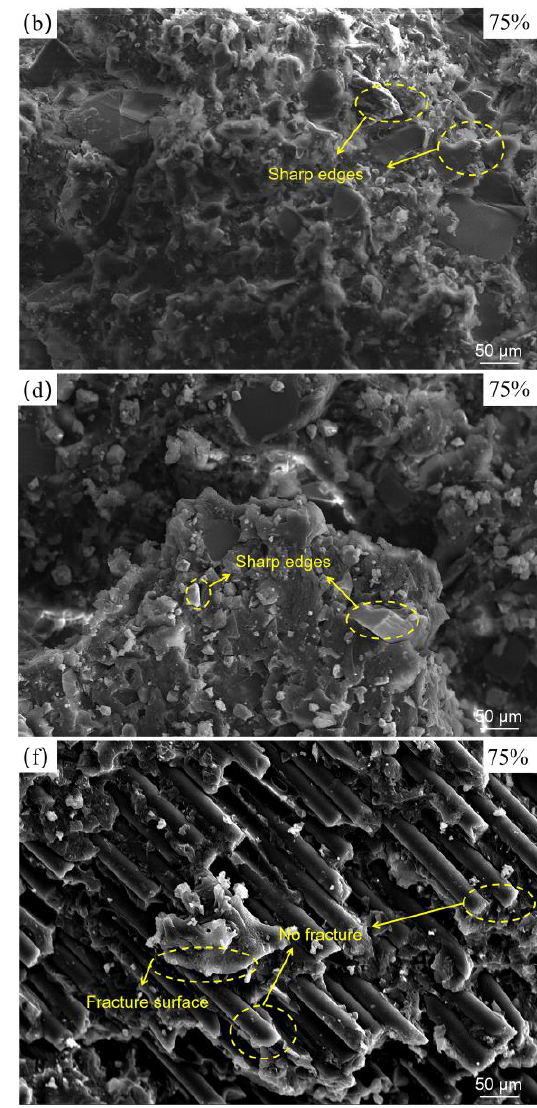
Figure 10. Cross-sections of adhesive joints: ( a ) no cyclic load applied and ( b ) cyclic load applied at 35% load level.